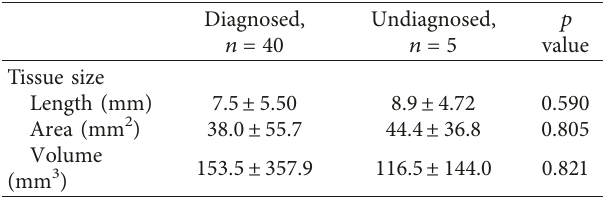
Table 3: Comparison of tissue size between the diagnosed group and the undiagnosed